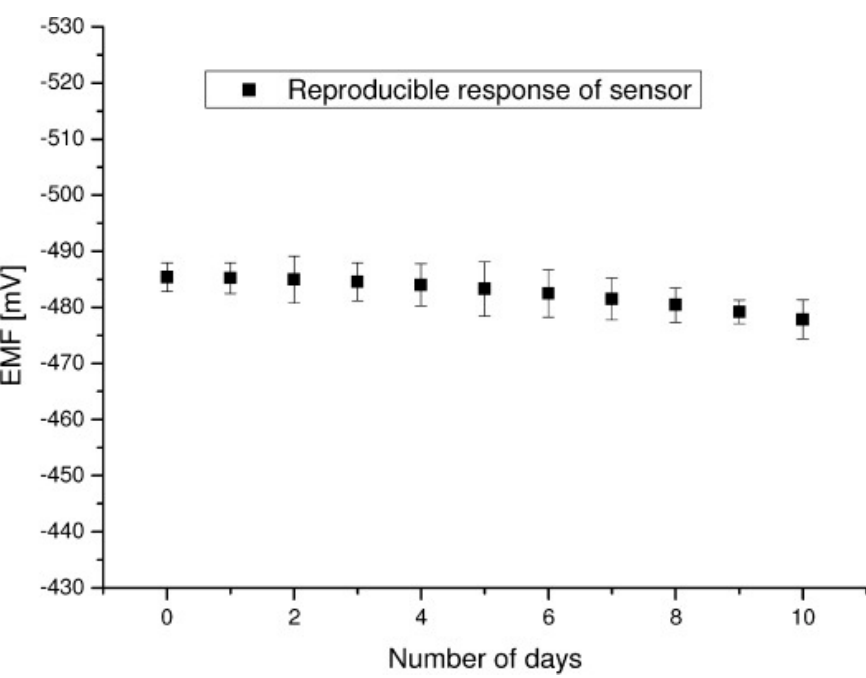
Figure 5 . Carbofuran sensor reproducibility/reusability at room temperature after 2–3 h span in 100 mM carbofuran solution (from Reference [21] with permission).